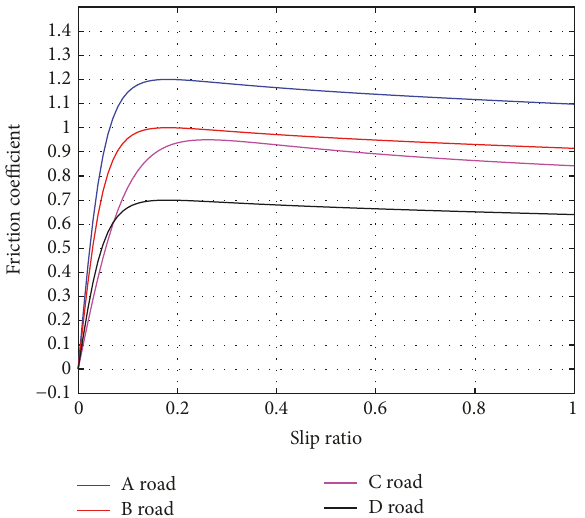
Figure 13: Sensitivity analysis: effect of the variation of slip condi-